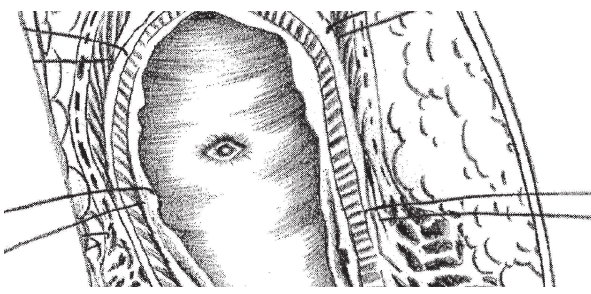
Figure 4 - Separation of the two flaps of the rectal wall of the